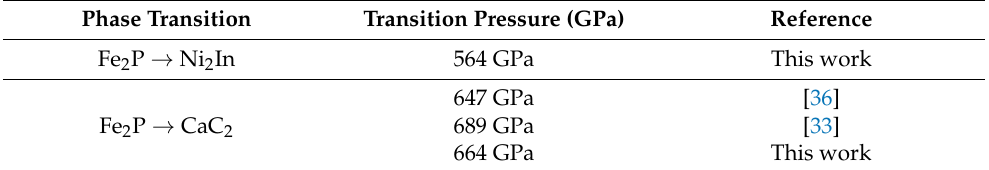
Figure 3. Change in enthalpy with respect to Fe 2 P phase versus pressure of one formula unit as determined by GGA calculations for TiO 2 . The transition pressures across transitions from Fe 2 P to Ni 2 In and CaC 2 phases are shown. Table 2. Calculated transition pressures across the Fe 2 P → Ni 2 In and Fe 2 P → CaC 2 phase transitions for TiO 2 . For comparison, we list other calculated results.